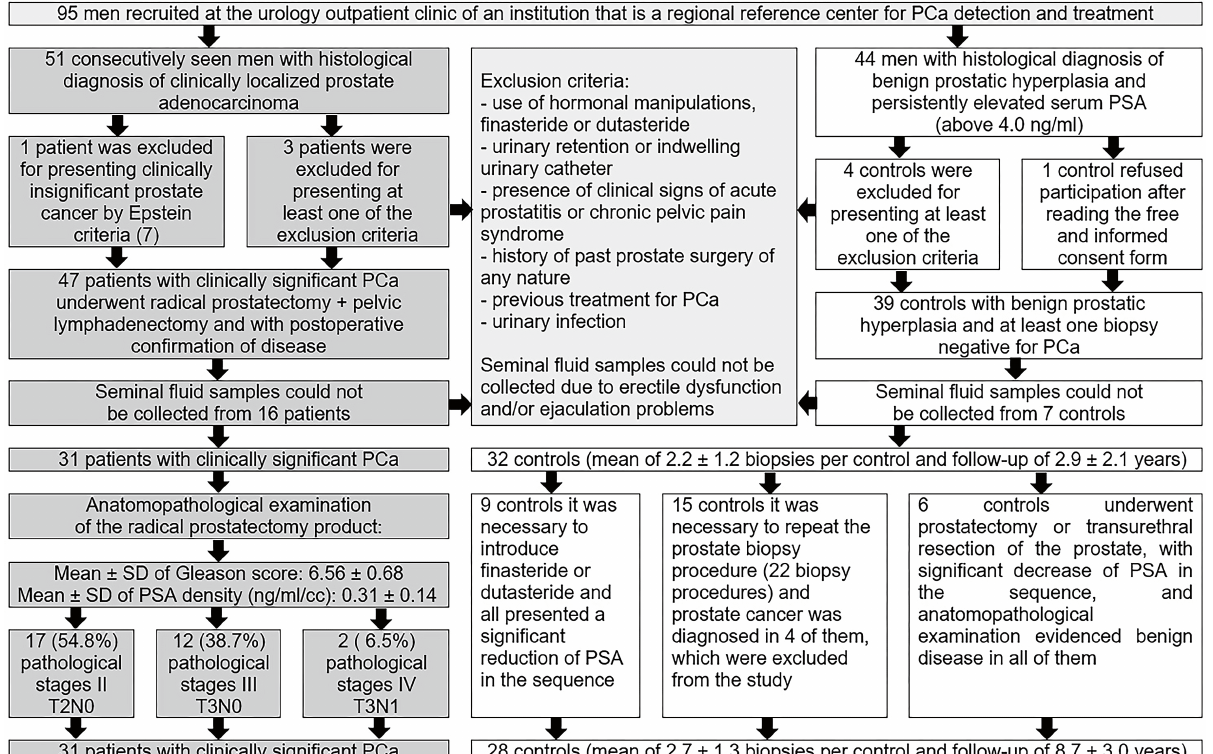
Figure 1 - Distribution of patients and controls and the flowchart of exclusion and follow-up of the